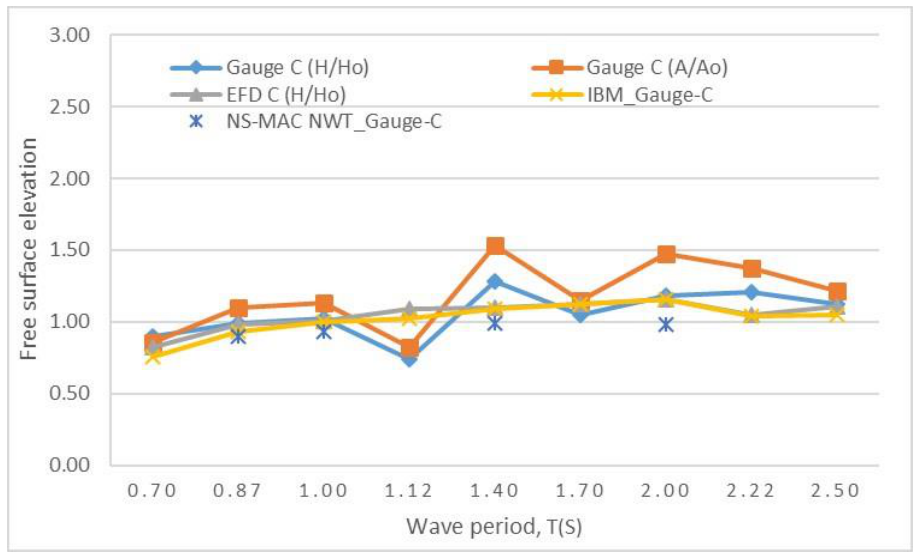
Figure 7. Comparison between CFD, experimental and numerical data of wave amplitude and heights for location C [5,25,26].